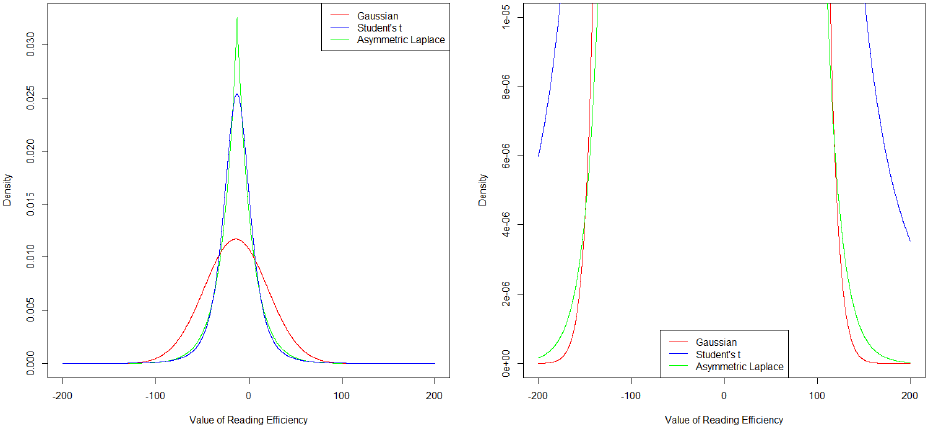
Figure 2. Distribution density plots for the following distributions (cf. Table 2): N ( − 13.98, 34.10), t ( − 12.79, 14.55, 3.22), and ALD ( − 12.70, 7.67, 0.50). These are the distributions based on the estimated models reported in Table 2 for reading efficiency at the first measurement point for the average student. Left: y -axis range from 0 to 0.035 and x -axis range from − 200 to 200. Right: “zoom-in” depiction of the densities to better visualize differences at the tails, i.e., y -axis range from 0 to 0.00001 and x -axis range from − 200 to 200.